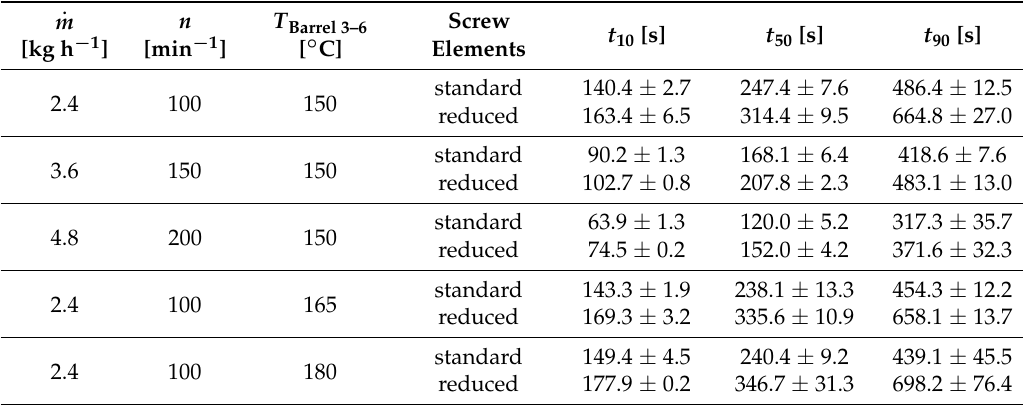
Table 2. Characteristic quantiles represented as mean value ± standard deviation ( n = 3) of the determined RTD for a constant SFL =